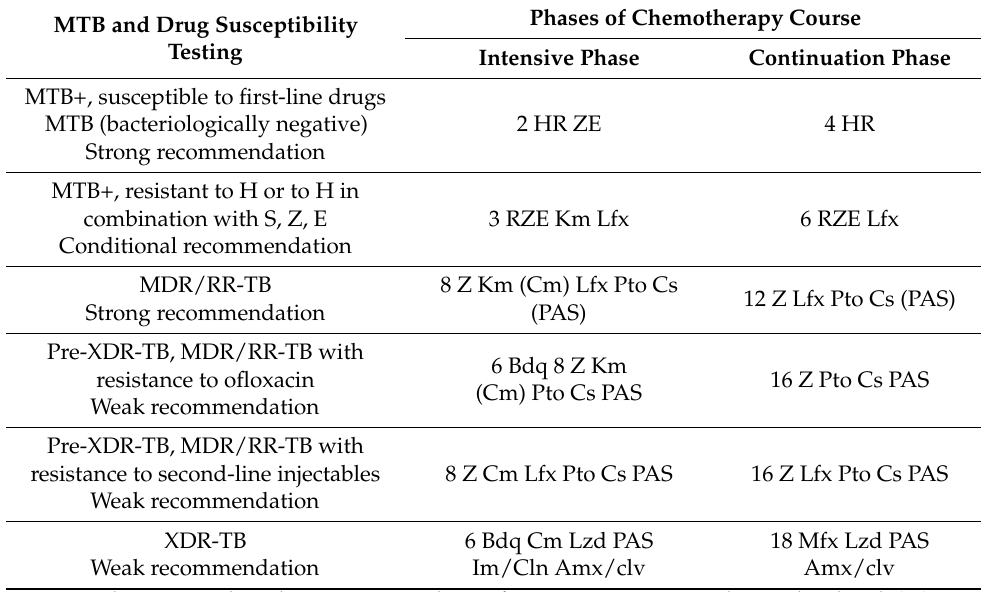
Table 4. Recommended dosages for pediatric TB drugs formulations for children with tuberculosis in Uzbekistan, 2019. Daily Dose Drug